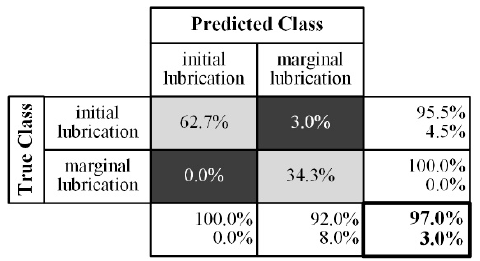
Figure 13. Assessment of the data model accuracy with a confusion matrix.